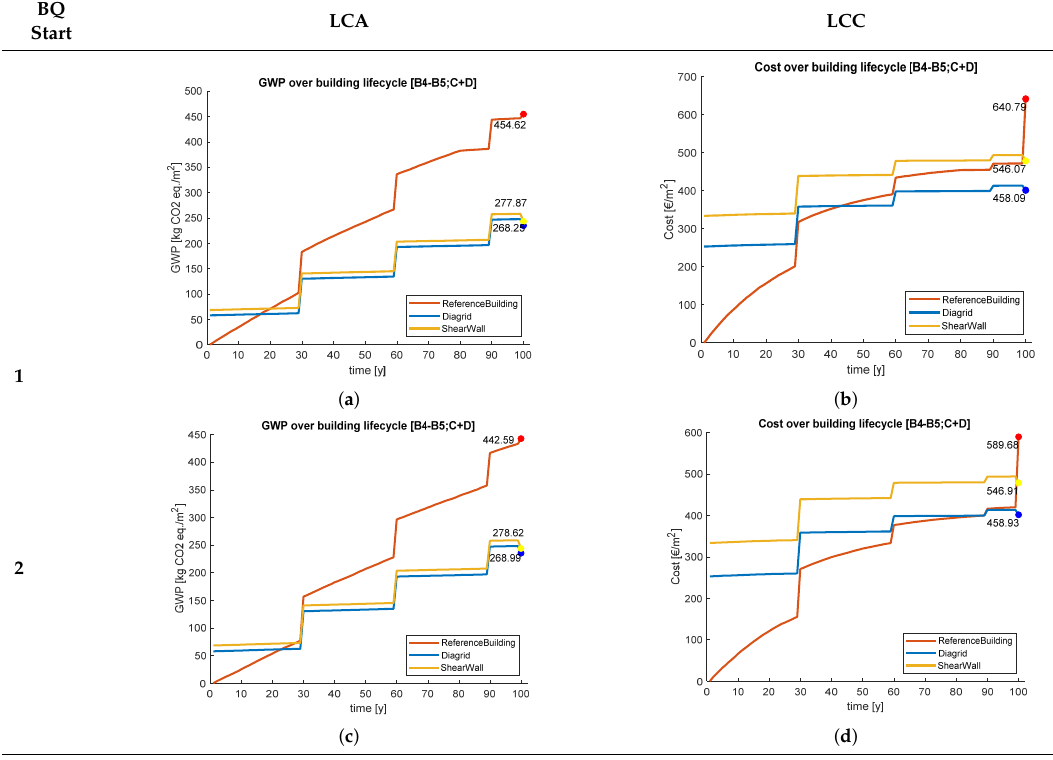
Table A2. Probabilistic LCA–LCC results with BQ variation due to earthquake occurrence. BQ Start